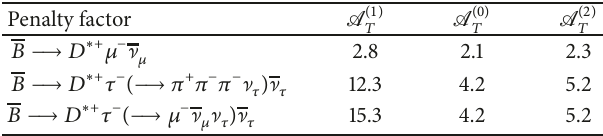
Table 6:Decrease inprecision on the 𝐶𝑃 -violatingobservables with respect to perfect decay reconstruction, as determined from the slope of the TPA = 𝑓( A 𝑇 )